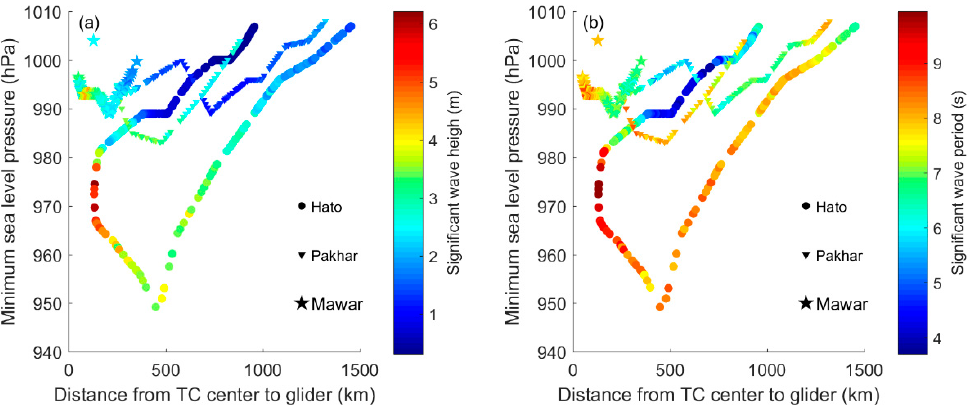
Figure 4. Dependency of wave parameters on TC intensity and the distance from TC center to glider: ( a ) significant wave height (color coding); ( b ) significant wave period (color coding).